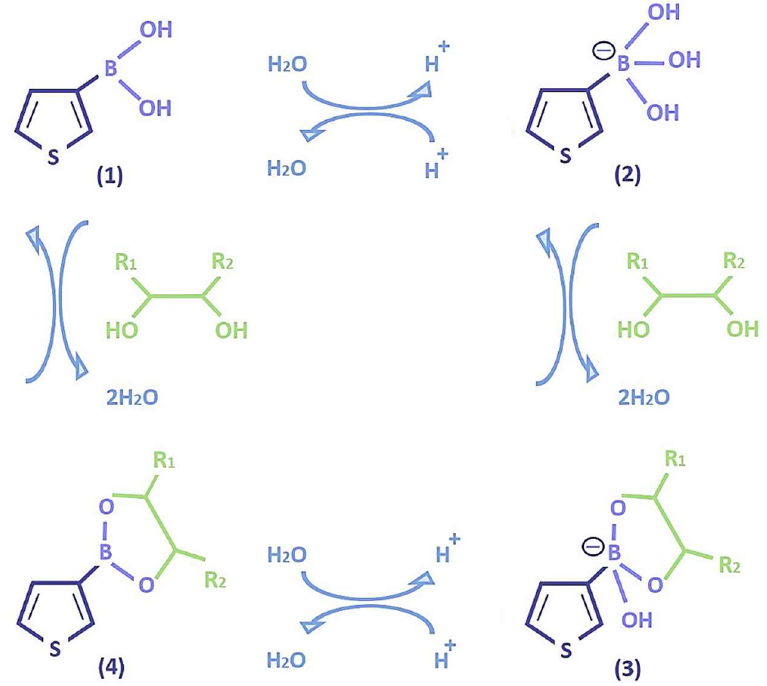
Figure 1. Equilibrium between 3-thienylboronic acid and its ester upon interaction with 1,2- or 1,3-diols in an aqueous solution. The scheme is based on the early suggested scheme for PBA [41].